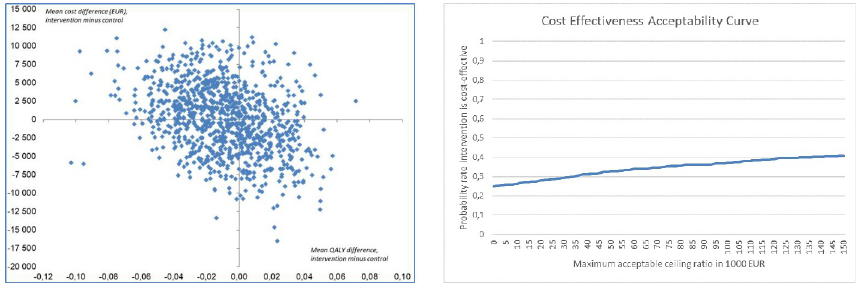
Fig 3. The cost-effectiveness plane (left, Fig 3A) and cost-effectiveness acceptability curve (right, Fig 3B).